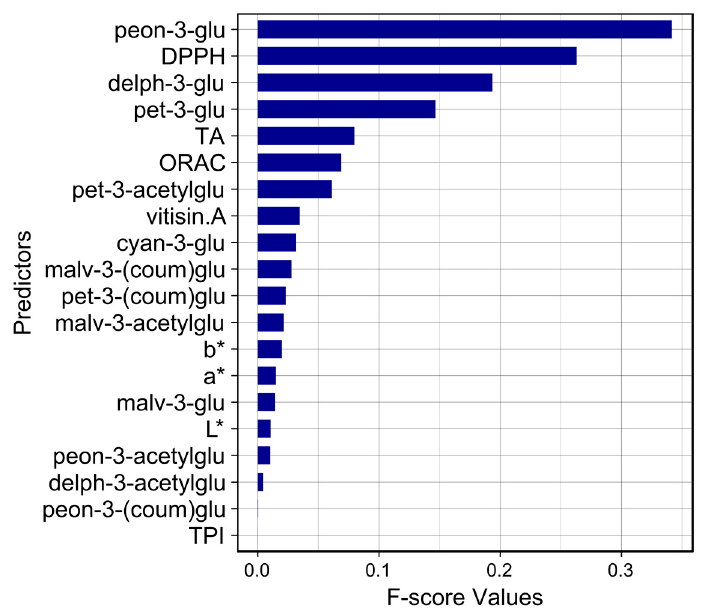
Figure 3. F ‐ score ranking of importance. Figure 3. F -score ranking of